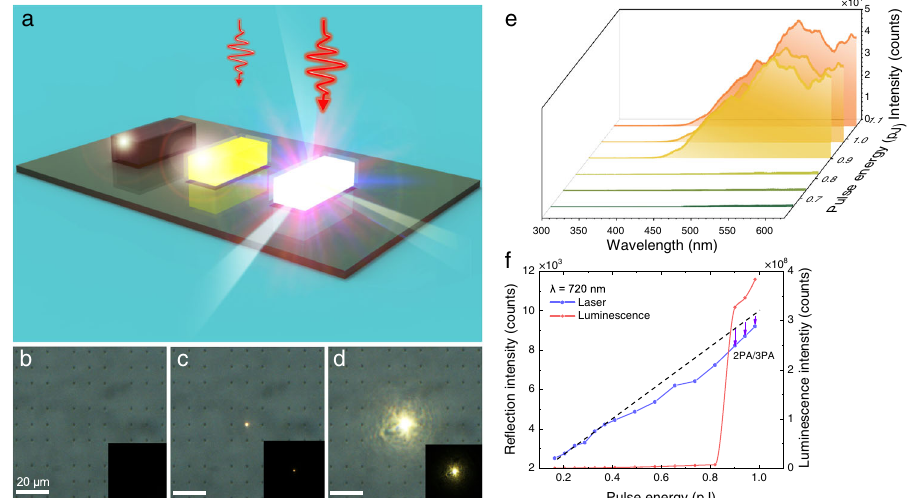
Fig. 4 Luminescence burst observed for Si/SiO 2 cuboids. a Schematic showing the burst of hot electron luminescence from a Si/SiO 2 cuboid with increasing excitation pulse energy. b – d Evolution of the luminescence with increasing excitation pulse energy observed for a Si/SiO 2 cuboid ( l = 440 nm, w = 260 nm) recorded by using a coupled charge device. e Evolution of the luminescence spectrum of the Si/SiO 2 cuboid with increasing pulse energy. f Dependences of the luminescence intensity and the re fl ected laser light intensity on the excitation pulse energy obtained for the Si/SiO 2